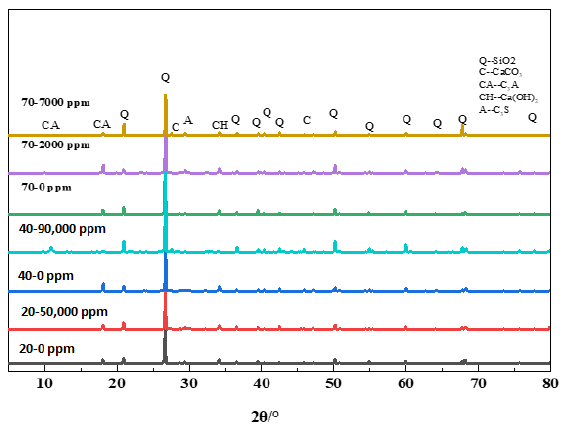
Figure 8. X-ray diffraction (XRD) patterns of concrete except 70–180,000 ppm at 180 days.